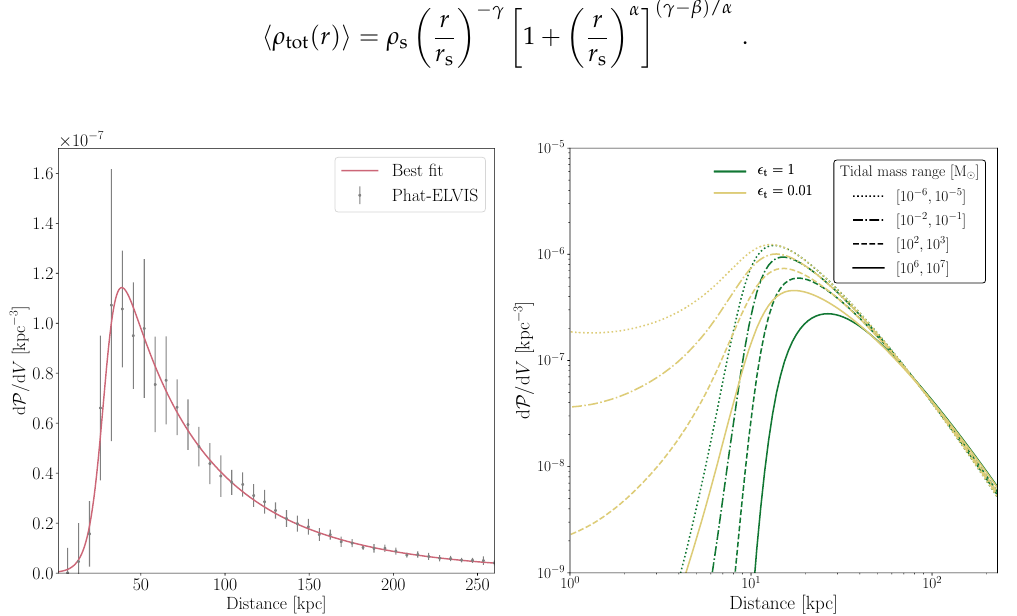
Figure 1. Spatial PDFs of subhalos surviving interaction with the baryonic disk potential. ( Left panel ): directly computed from the catalogs of the Phat-ELVIS simulations [10]. Dots correspond to the average over the 12 Milky-Way-like halos in the simulations, with error bars obtained from the dispersion over the 12 halos. The best-fit model (red curve) has been computed using the parametrization given by Equation (5). ( Right panel ): SL17 model for various mass ranges (line styles) and values of (cid:101) t (colors). See Figure 2 for a comparison between all d /d V models used in the P